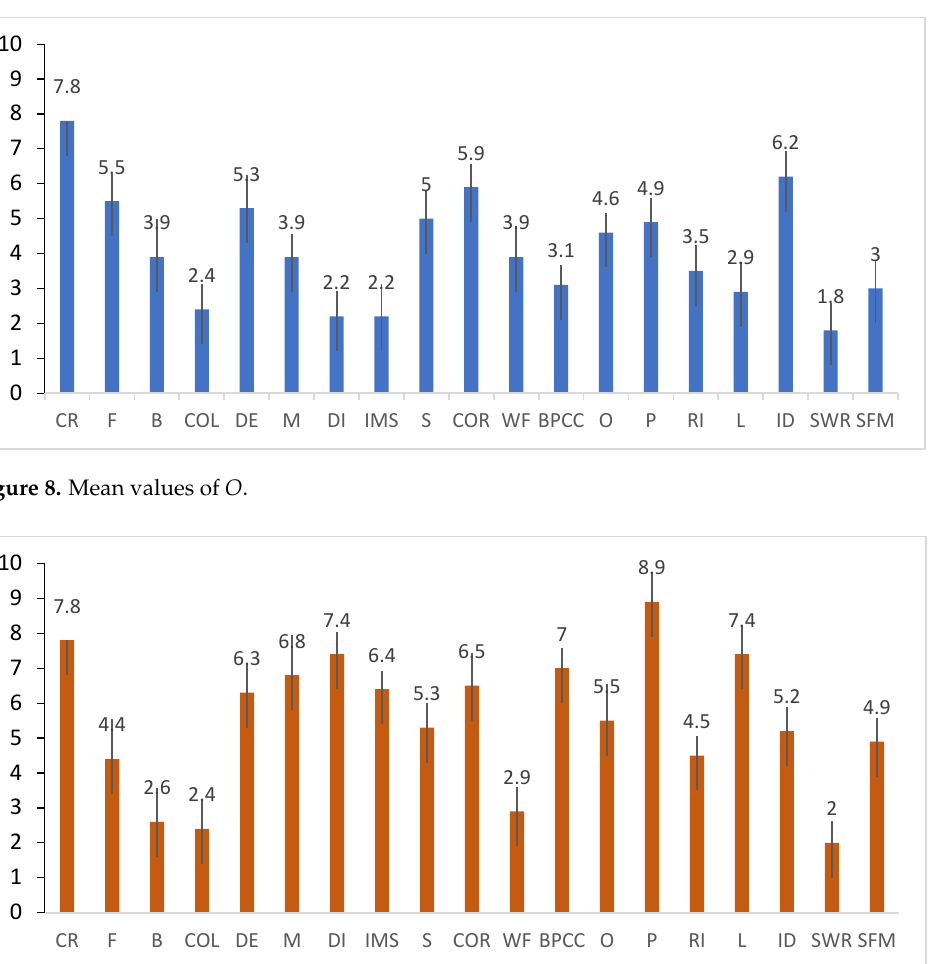
Figure 7. Mean values of 𝑆 .